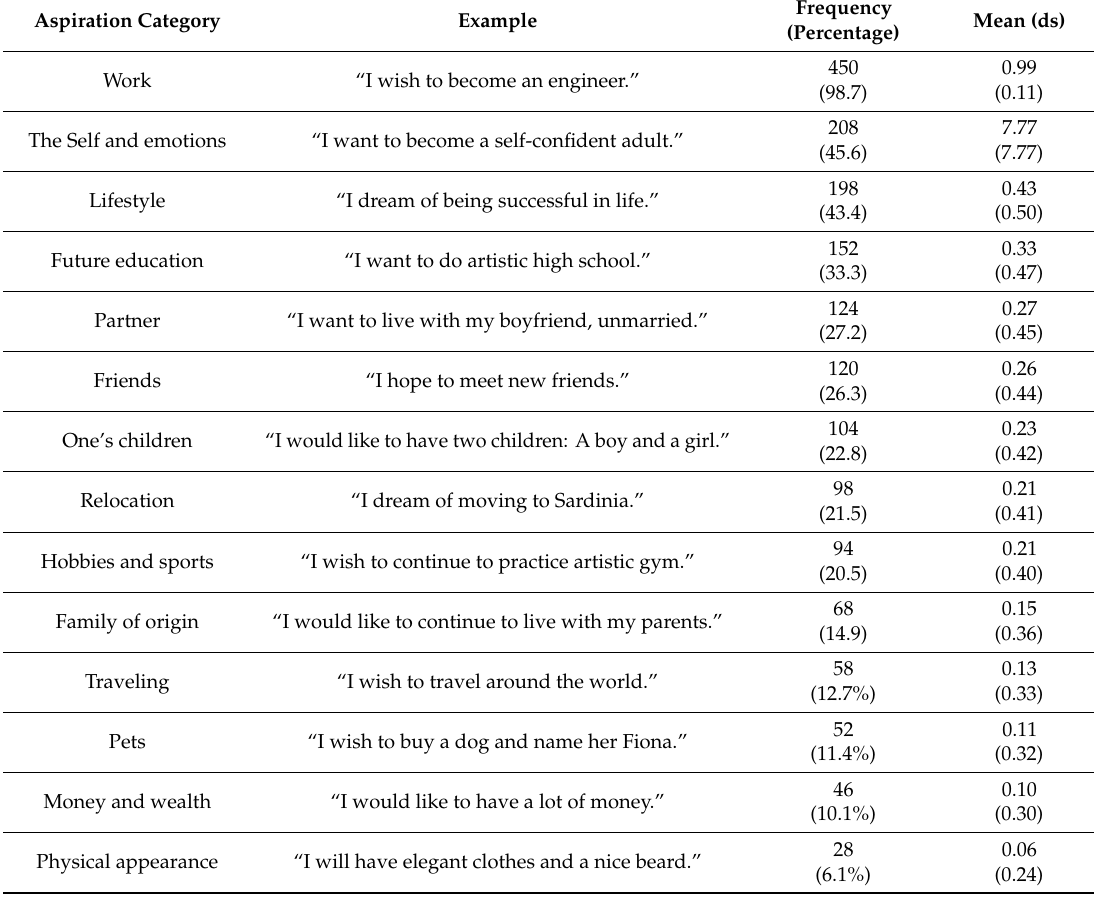
Table 1. Aspiration categories, examples, and descriptive